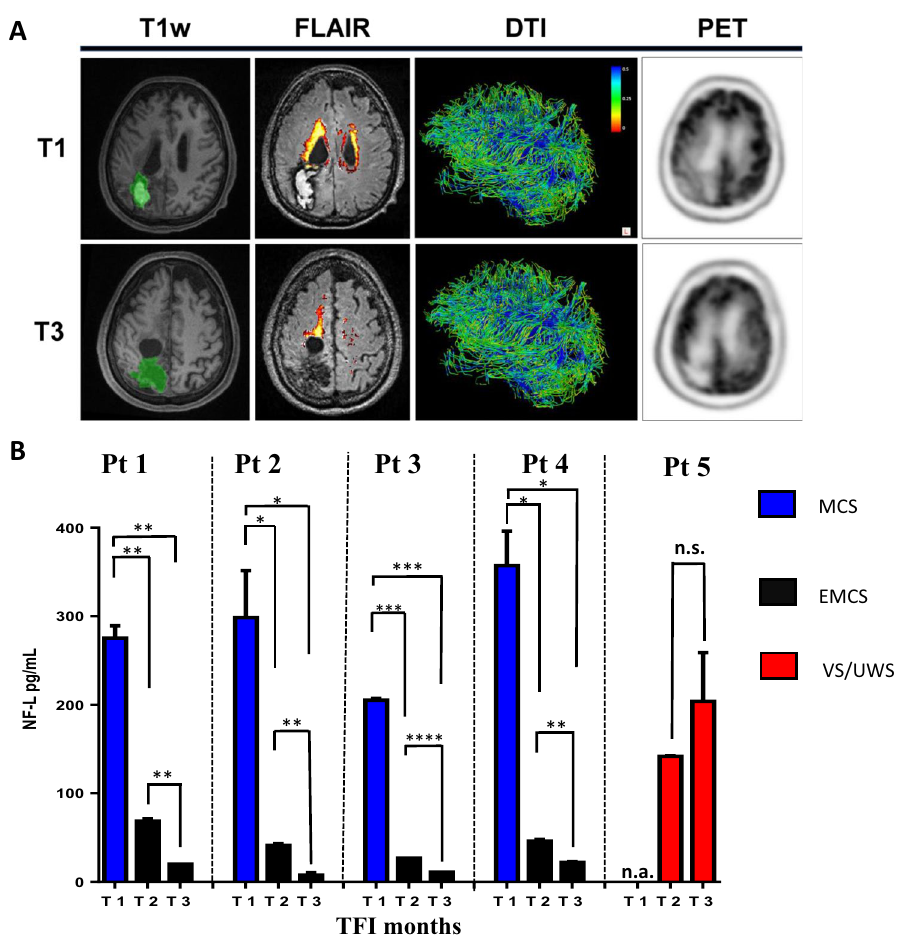
Figure 4. ( A ) PET/MRI scans of a 60yo patient with hemorrhagic parieto-occipital lesion and secondary enlargement of correspondent lateral ventricle, following percutaneous transluminal coronary angioplasty (T1 [VS/UWS] and T3 [EMCS], respectively at 4 and 18 months since injury). From left to right, a T1w sequence showing segmented hemorrhagic lesion (green) with blood hyperintense signal in transparence at T1; a FLAIR sequence with automatic LPA-segmentation of mostly periventricular hyperintense gliotic alterations; DTI reconstruction of streamlines encoded for scalar FA value (brain lateral view); axial view of 18F-FDG PET at both the time points. ( B ) The serum NF-L marker was evaluated in n = 5 pDoC patients at 1–6, 7–12, and 13–18 months after brain injury.* = p -value < 0.05.** = p -value < 0.01.*** = p -value < 0.001.**** = p -value < 0.0001. The values of selected markers were obtained from two independent measurements. TFI = time from injury expressed in months. n.a. = not applicable. The blue columns refer to MCS; the red ones to VS/UWS; the black ones to